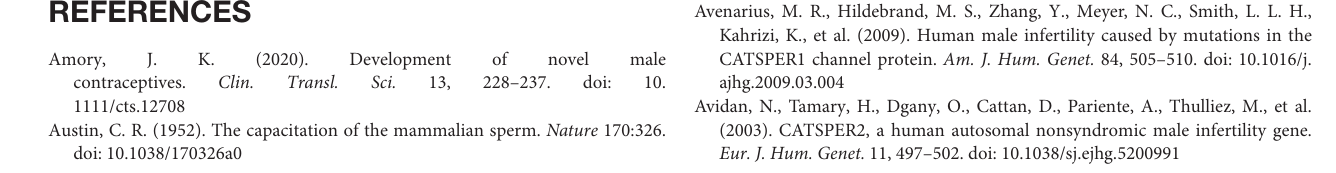
Supplementary Figure 1 | Effect of HC on sperm progressive motility analyzed by CASA. Percentage of progressive motility evaluated by CASA for sperm incubated under capacitating conditions for 90 min in medium containing 1 or 5 µ M HC or DMSO (vehicle) as control. Higher concentrations of HC (10 or 20 µ M) severely affected sperm motility preventing reaching the at least 200 motile sperm required for CASA analysis. Data are mean ± SEM of at least n = 3 independent experiments; ∗ p < 0.05 vs. DMSO. Supplementary Table 1 | Sperm motility parameters analyzed by CASA. CASA parameters analyzed for sperm incubated under capacitating conditions for 90 min in medium containing 1 or 5 µ M HC or DMSO (vehicle) as control. Data are mean ± SEM of at least n = 3 independent experiments; ∗ p < 0.05; ∗∗ p <